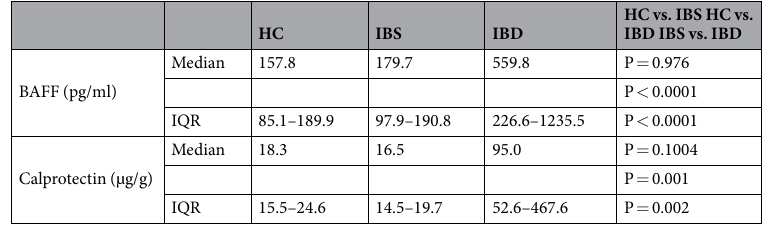
Table 2. Test Characteristics of Faecal BAFF and Calprotectin. HC, healthy controls; IBS, irritable bowel syndrome; IBD, inflammatory bowel disease. IQR interquartile